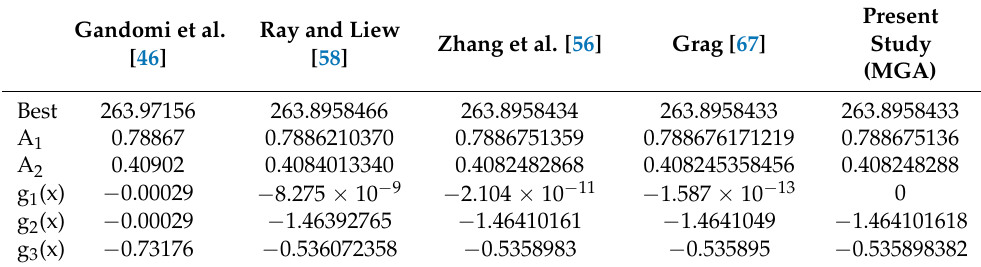
Table A9. Comparison of the best solutions for the three-bar truss design problem.